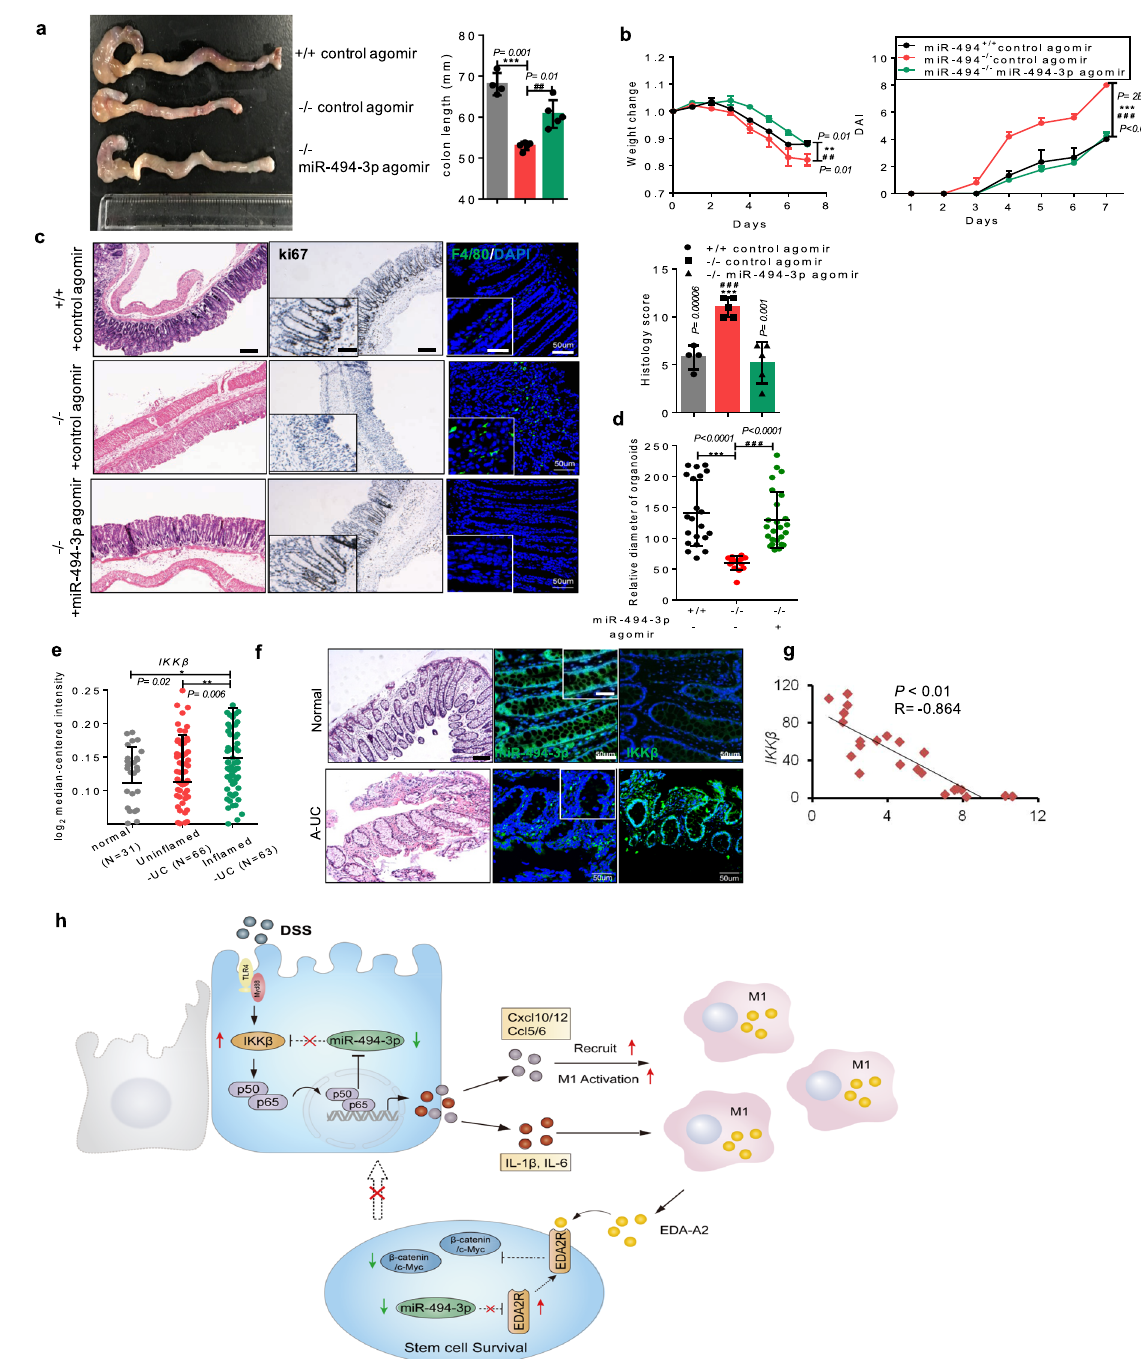
Fig. 7 Administration of miR-494-3p agomir protects mice from colitis. a – d miR-494 − / − mice and WT ( + / + ) mice at 8-weeks old were provided with free access to 3% DSS in the drinking water for 7 days. miR-494-3p agomir or control agomir was administered by intravenous at days 0, 2, and 4 (where day 0 is the initial time point of DSS treatment). a Typical images of the colon and statistical plot of colon length which was measured at day 7 after sacri fi ce. b Body weight changes and DAI. c H&E images of colon tissue (scale bar: 200 μ m) and histology score (0 – 12). IHC staining of colon tissues for proliferation marker Ki67 (scale bar: 200 μ m, scale bar of close-up image: 100 μ m) and IF staining for macrophage marker F4/80 (scale bar: 50 μ m, scale bar of close-up image: 25 μ m). d Quanti fi cation of the diameter of organoids derived from the mice ( c ). e IKK β expression in the colon from normal tissues, unin fl amed UC tissues or in fl amed UC from the GSE11223 datasets. f Representative images of colon from healthy subject and patients with active IBD showing histopathology (scale bar: 200 μ m) and the correlation between miR-494-3p and IKK β (scale bar: 50 μ m, scale bar of close-up image: 25 μ m). g Expression of IKK β and miR-494-3p in human active IBD samples and normal colon tissues. h A schematic fi gure for the model. Data are presented as mean ± S.D. and analyzed by non-paired two-tailed Student ’ s t- test in the graphs in ( a – e , g ). *Indicating the signi fi cance between WT ( + / + ) control agomir and miR-494 − / − ( − / − ) control agomir; # indicating the signi fi cance between − / − control-agomir and − / − miR-494-3p agomir. ***/ ### P ≤ 0.001; **/ ## P ≤ 0.01; */ ## P ≤ 0.05. COMMUNICATIONS BIOLOGY| (2021) 4:213